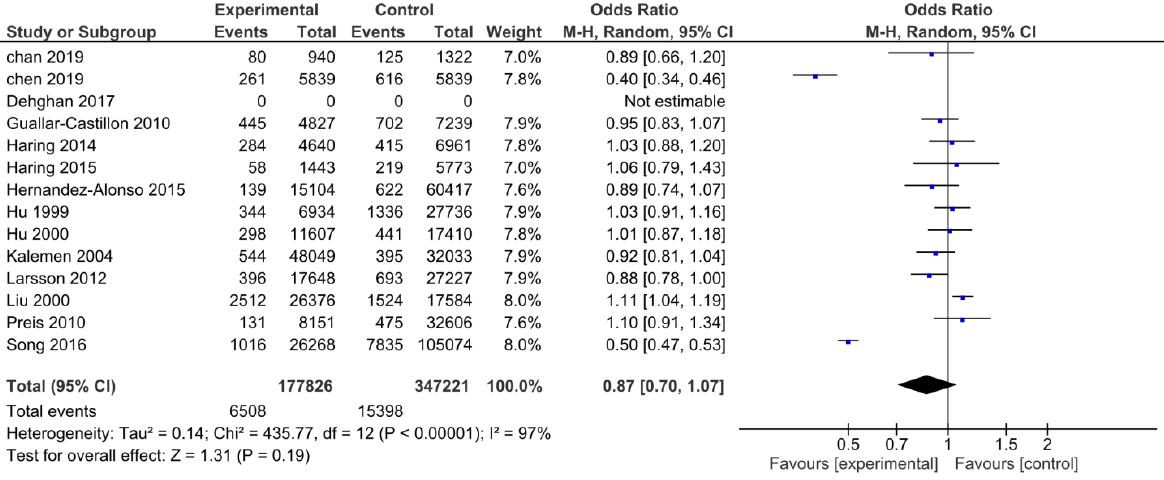
Figure 5. Forest plot for the association between HP intake and the composite endpoint of non-fatal myocardial infarction, non-fatal stroke, and cardiovascular death. [13,15,23,25,49 – 58]. myocardial infarction, non-fatal stroke, and cardiovascular death